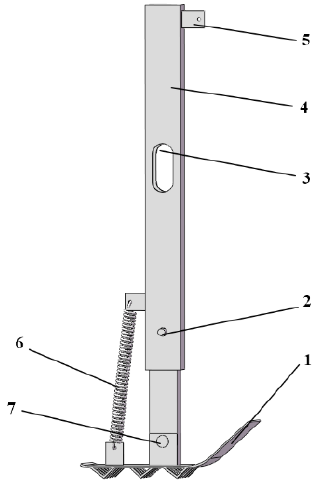
Figure 3. Motion analysis diagram of weeding wheel under ideal state.